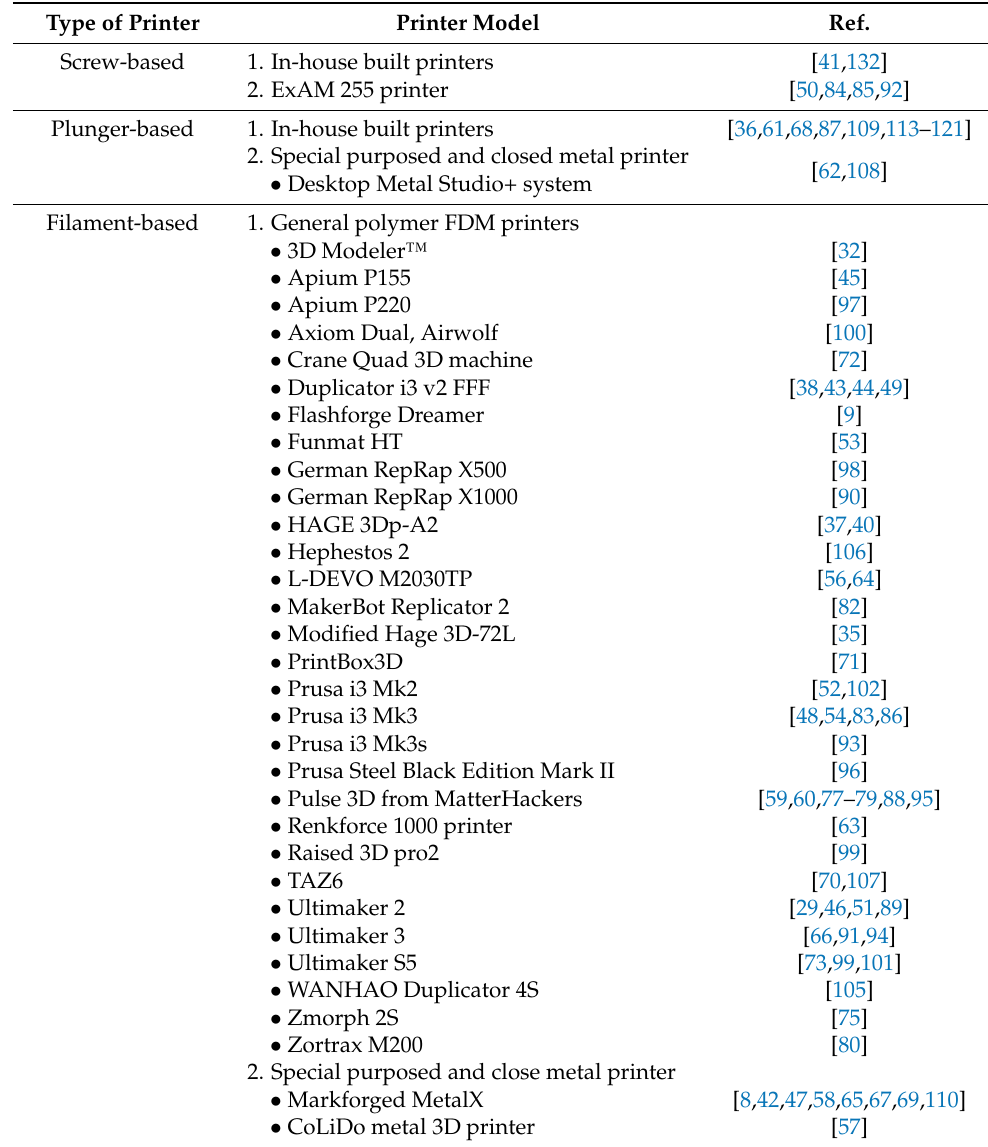
Table 1. 3D printers classified by feeding system and printer model as reported in the literature. Type of